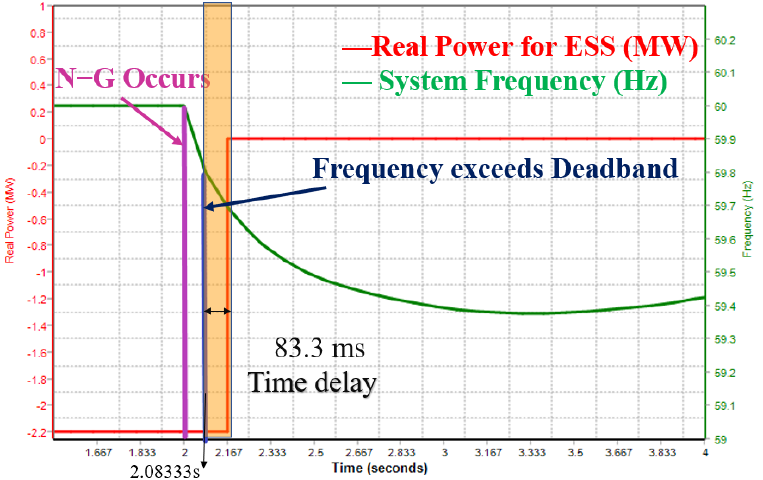
Figure 7. ESS 2 and ESS 3 grid frequency and real power output when N-1 contingency occurs while charging.